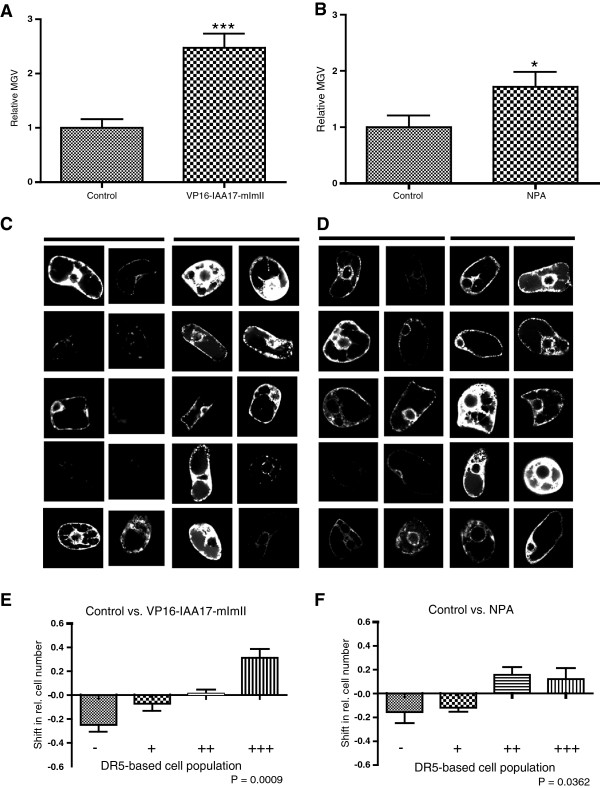
Effect of altered auxin signaling and transport capacity on cellular auxin homeostasis. (A,B) Graphs represent the relative average mean gray values (MGV) of the DR5rev:mRFP signal intensity. Error bars represent standard error (n = 60). Statistical significance was evaluated with the unpaired student T-test (* P < 0.05, ** P < 0.01, *** P < 0.0001). (A) Coexpression of DR5rev:mRFP and the stabilized version of IAA17 fused to a VP16 activator domain (35S:VP16-IAA17mImII), causing constitutive auxin signaling, significantly increased the relative average MGV compared to the 35S:HDEL-GFP-expressing control cells. (B) NPA treatment leads to an increased MGV/DR5 signaling compared to transformants maintained in standard cultivation medium. (C) 10 representative pictures are shown for the control cells (left panel) and the cells overexpressing VP16-IAA17-mImII (right panel). (D) 10 representative pictures are shown for the untreated control cells (left panel) and the cells treated with NPA (right panel). (E,F) Graphs depict the changes in relative number of transformed cells displaying a low (-), medium (+), high (++), and very high (+++) DR5rev:mRFP signal between the two samples addressing VP16-IAA17-mImII expression or NPA treatment (for detailed description of the quantification, see Additional file 1: Figure S2). Error bars represent standard error (n = 3 repetitions with at least 50 counted cells). Statistical significance was evaluated with the ANOVA test; the P-value is indicated.